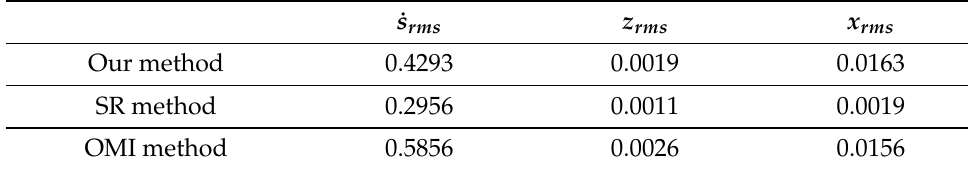
Table 7. Comparison with SR and